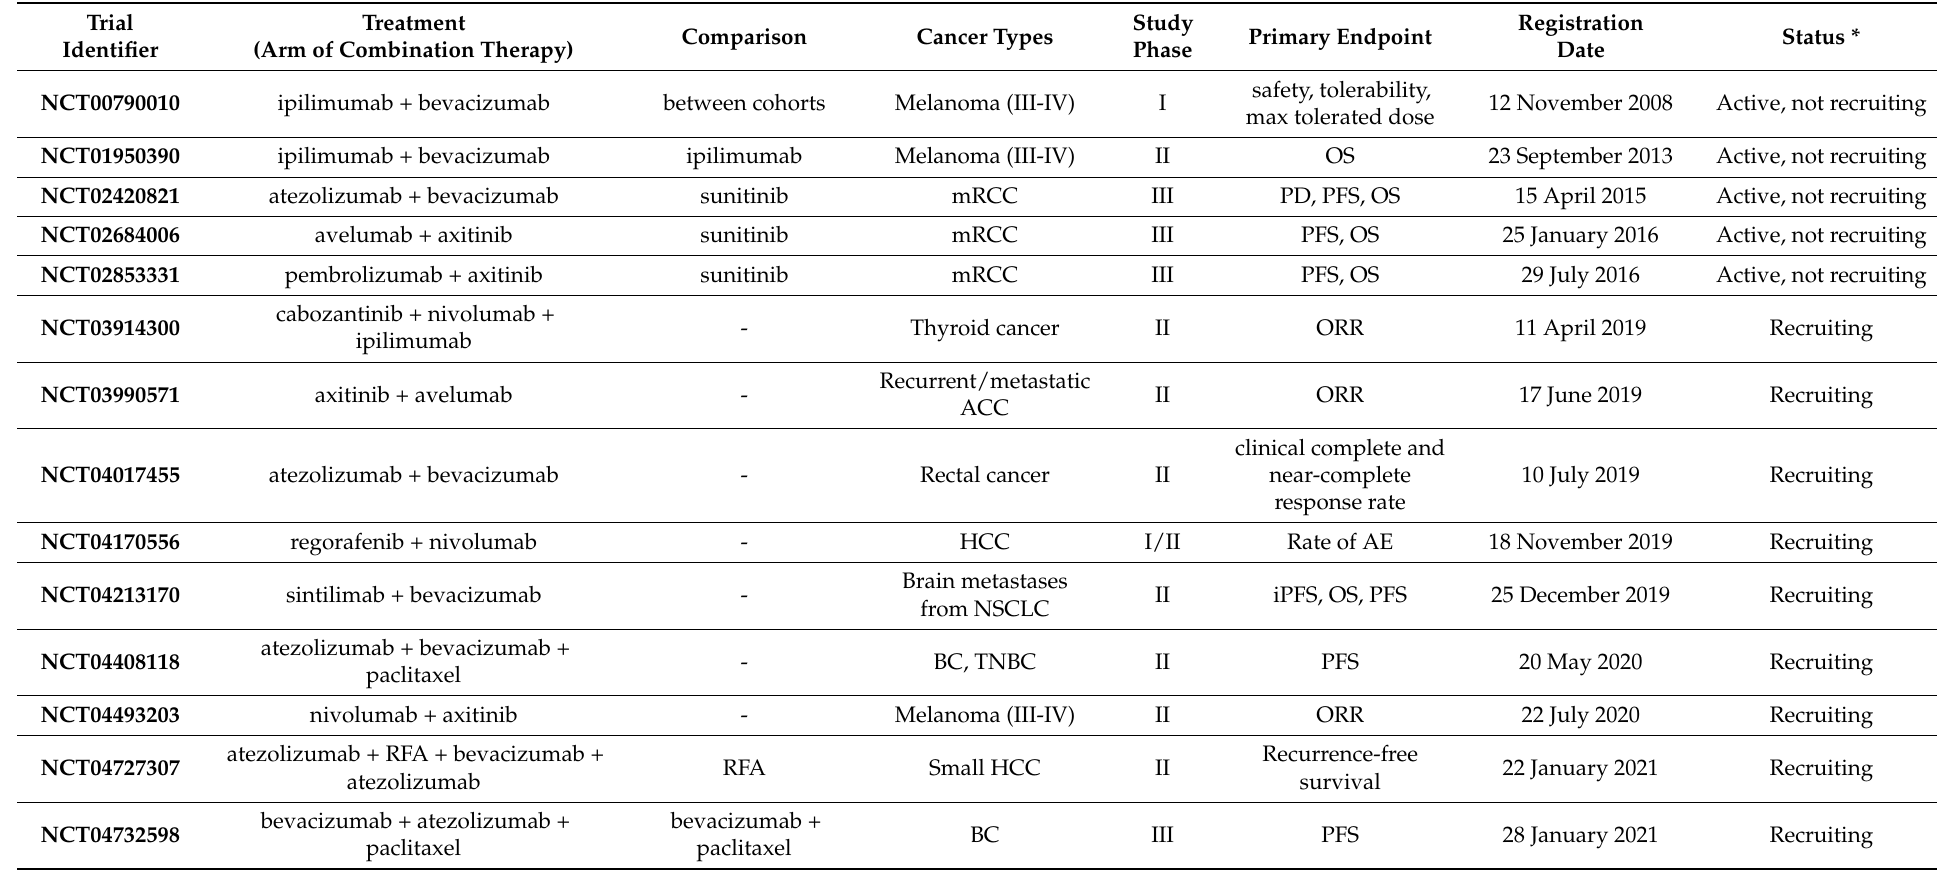
Table 1. Ongoing clinical trials evaluating immune-checkpoint inhibitors (ICIs) in combination with anti-angiogenic agents in solid